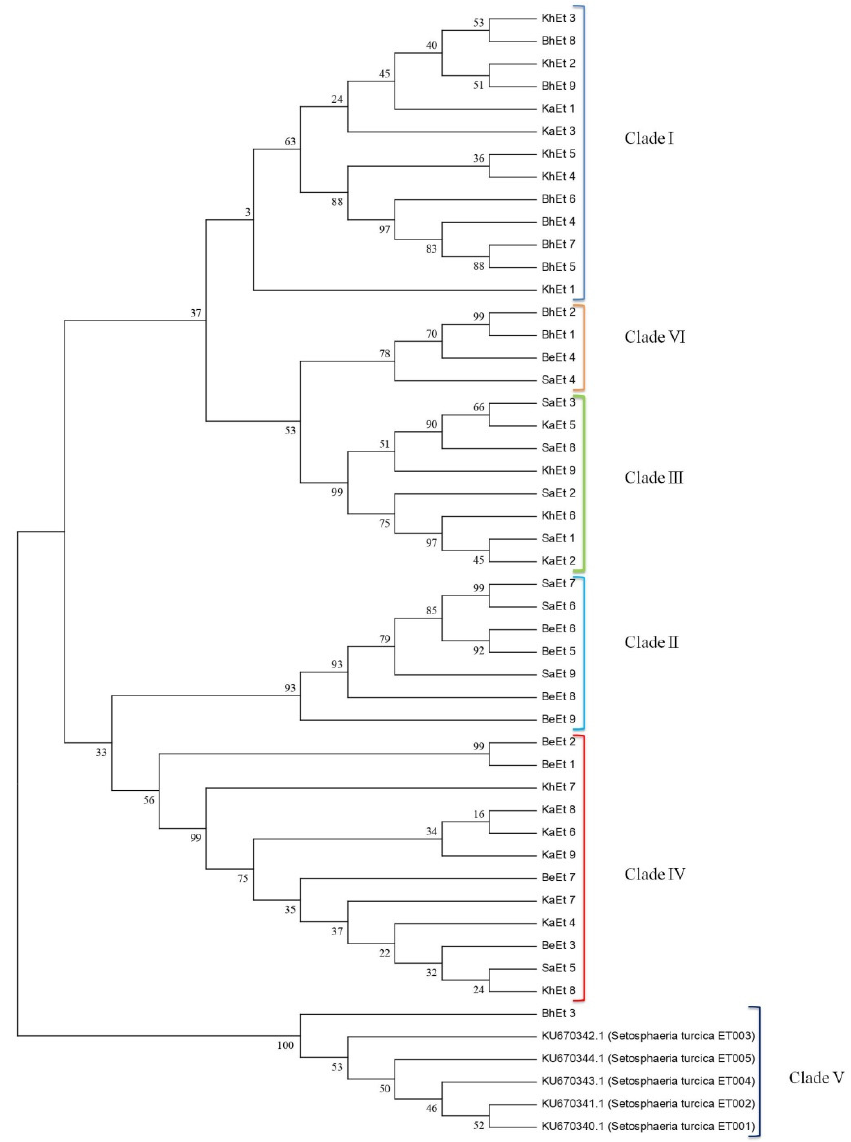
Figure 6. Phylogenetic relationships of 45 E. turcicum isolates compared with accession numbers of other species. Phylogenetic tree inferred by maximum likelihood analysis based on rDNA sequences. Numbers below the branches represent the percentage for each branch in 1000 bootstrap replications.